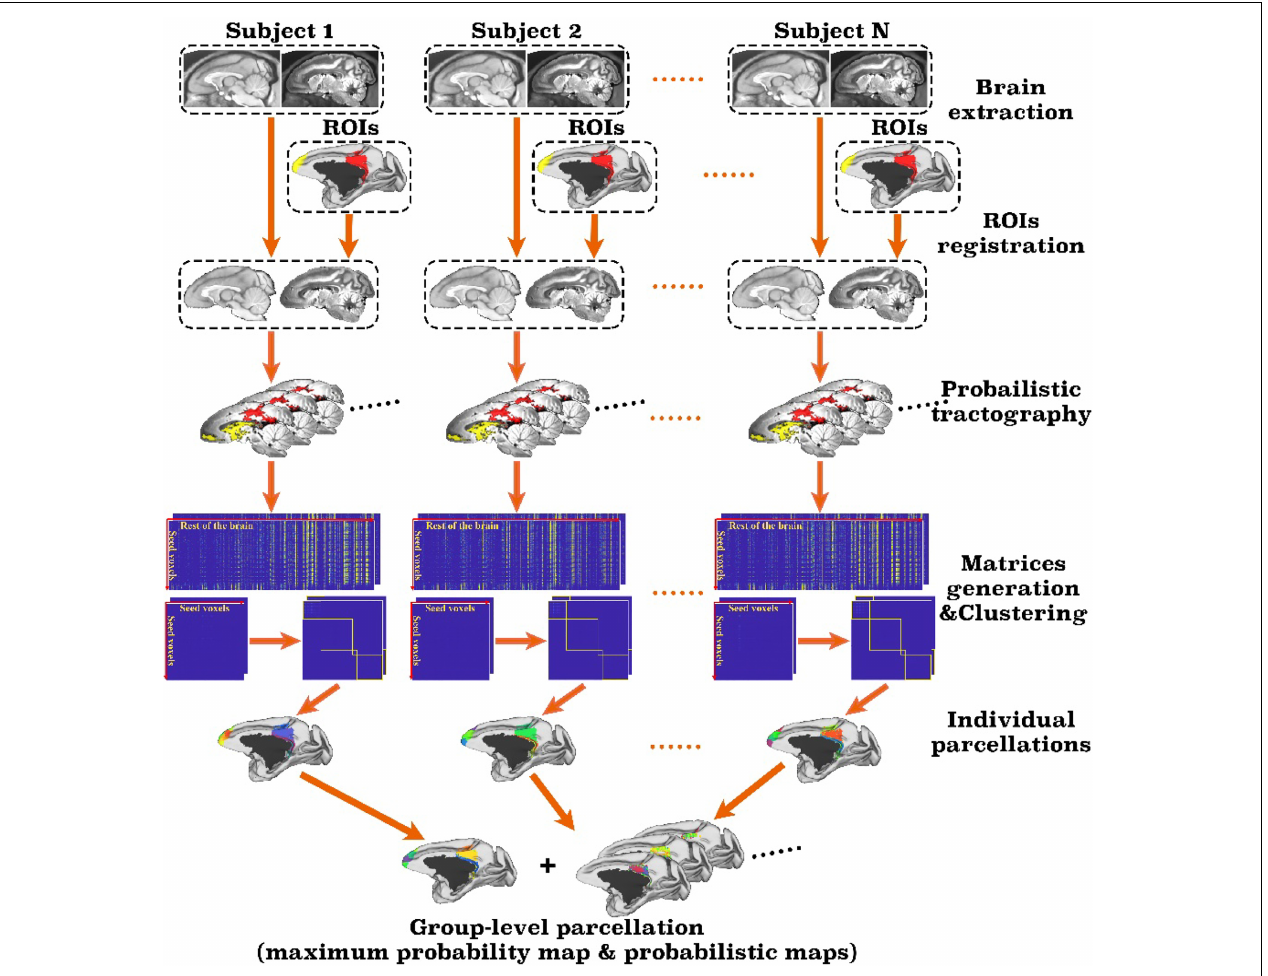
FIGURE 1 | Framework of the MonkeyCBP toolbox. The processing steps of the pipeline mainly including brain extraction, registration, probabilistic tractography, and clustering. First, the technique of brain extraction for monkey MRI data was performed; then based on T1w and diffusion tensor images of the same subjects, two defined regions of interest (ROIs), including the right posterior cingulate cortex and the bilateral frontal pole, are parcellated simultaneously. After pipeline processing, the parcellation results at both individual level and group level with a maximum probability map and probabilistic maps of each subarea of the right posterior cingulate cortex and the bilateral frontal pole are